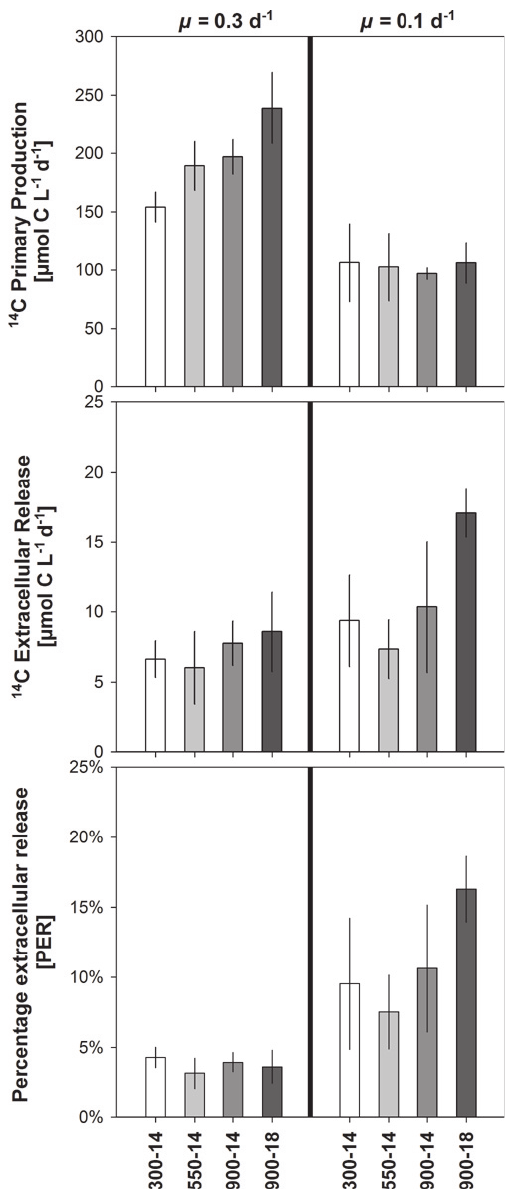
Fig. 1. Primary Production (upper panel), extracellular release (mid- dle panel) and percentage of extracellular release (PER, lower panel) at various growth-, CO 2 and temperature conditions. Mean values and standard deviations were derived from sampling 1, 2 and 3 ( µ = 0 . 3d − 1 ) and sampling 4, 5 and 6 ( µ = 0 . 1d − 1 ) , respec-